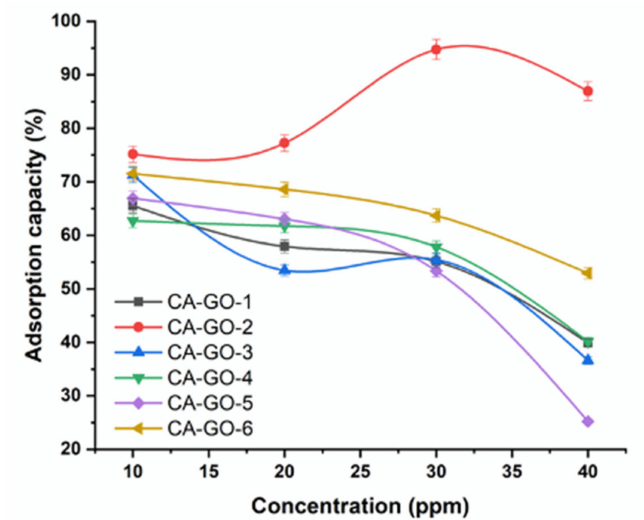
Figure 5. E ff ect of initial concentration on the adsorption of Ni 2 + onto